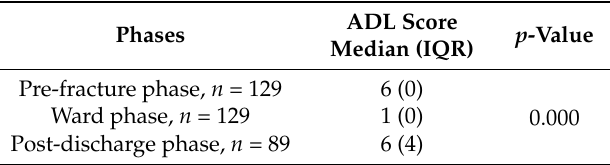
Table 6. Changes in ADL scores across all three